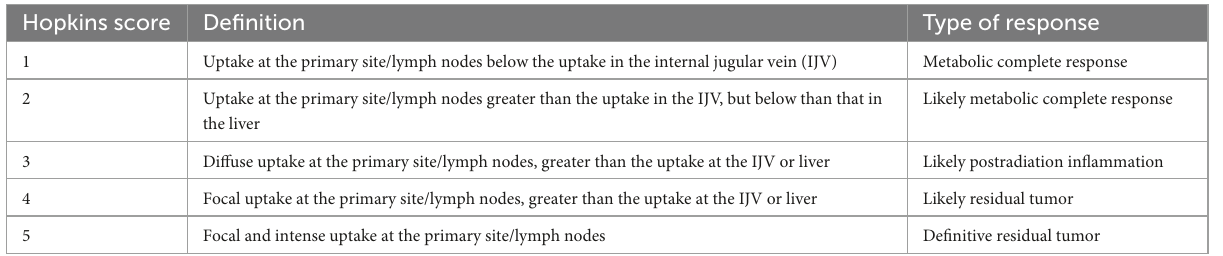
TABLE 1 Hopkins 5-point score and